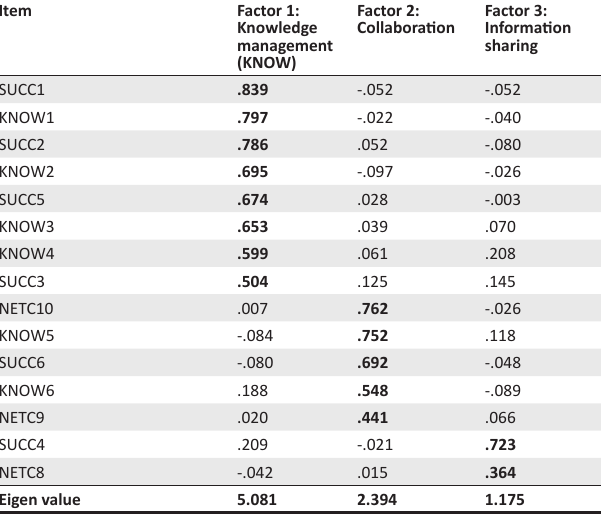
TABLE 2: Rotated factor loadings: Intervening variables .